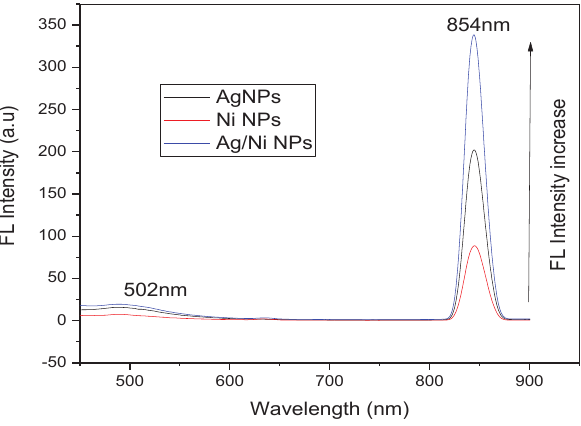
Figure 5: Fluorescence spectrum of silver, nickel mono and silver/ nickel bi-metallic nanoparticles using Z. root powder extract.